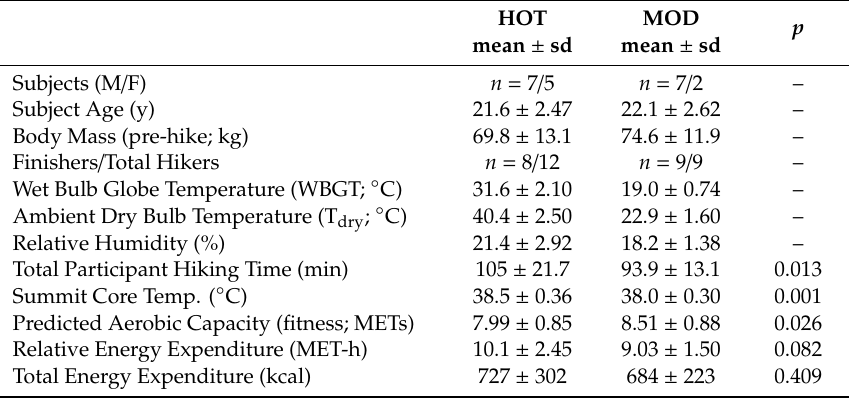
Table 1. Descriptive data for HOT and MOD